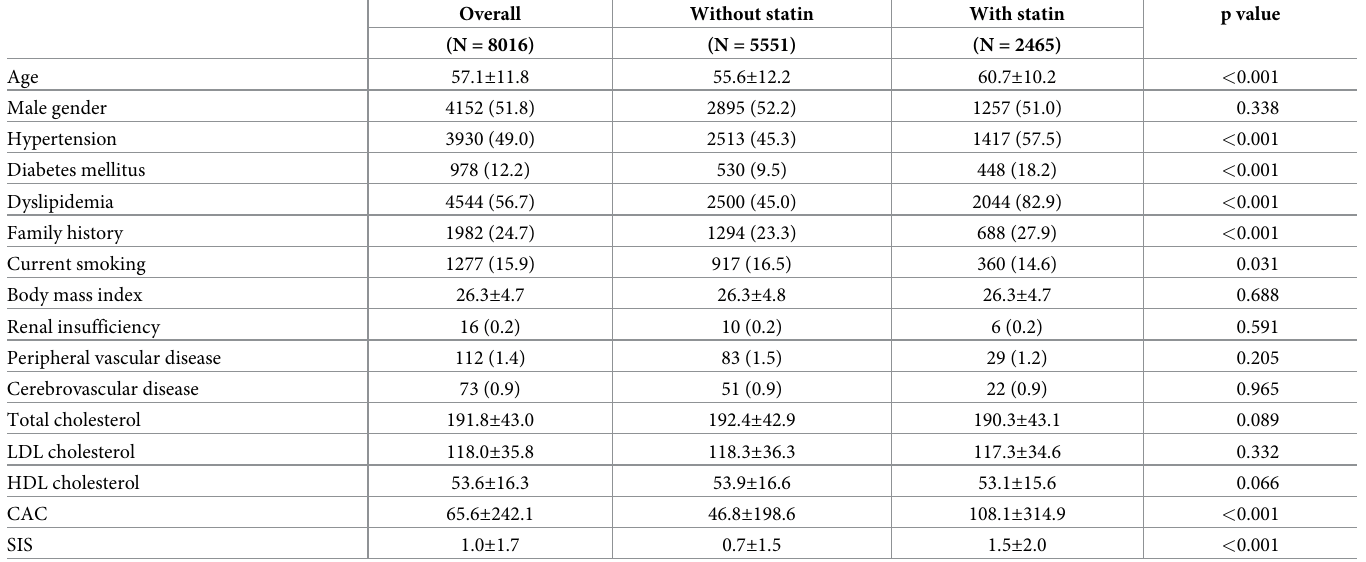
Table 1. Baseline